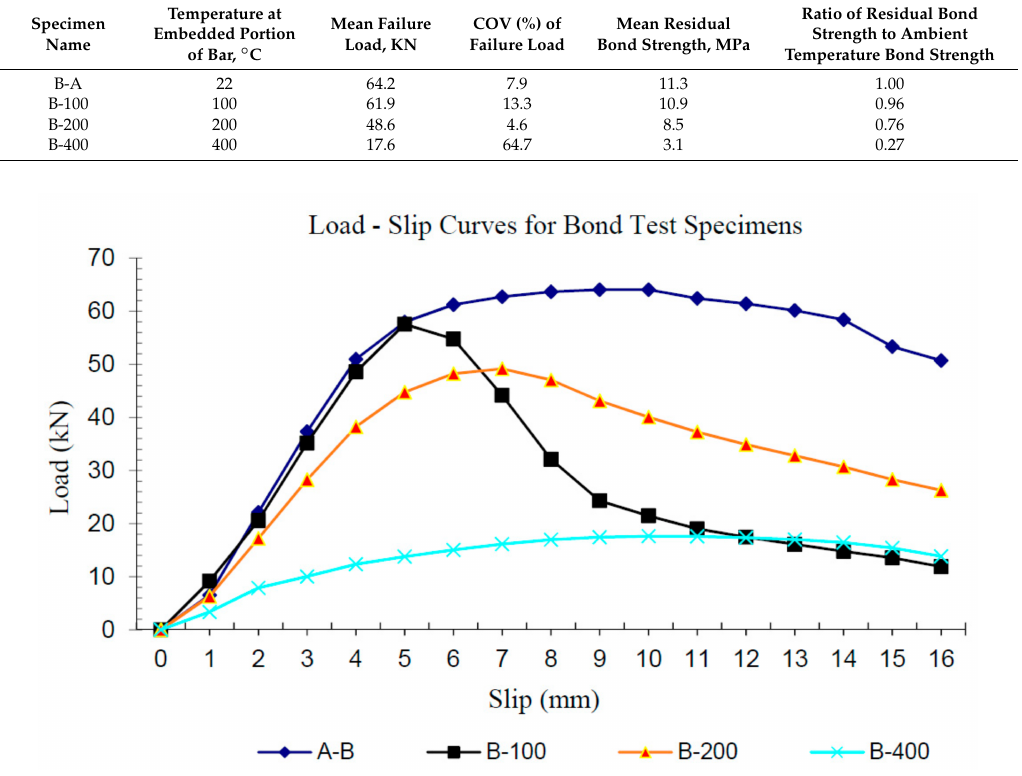
Figure 7. Comparison of mean load-slip curves for bond test